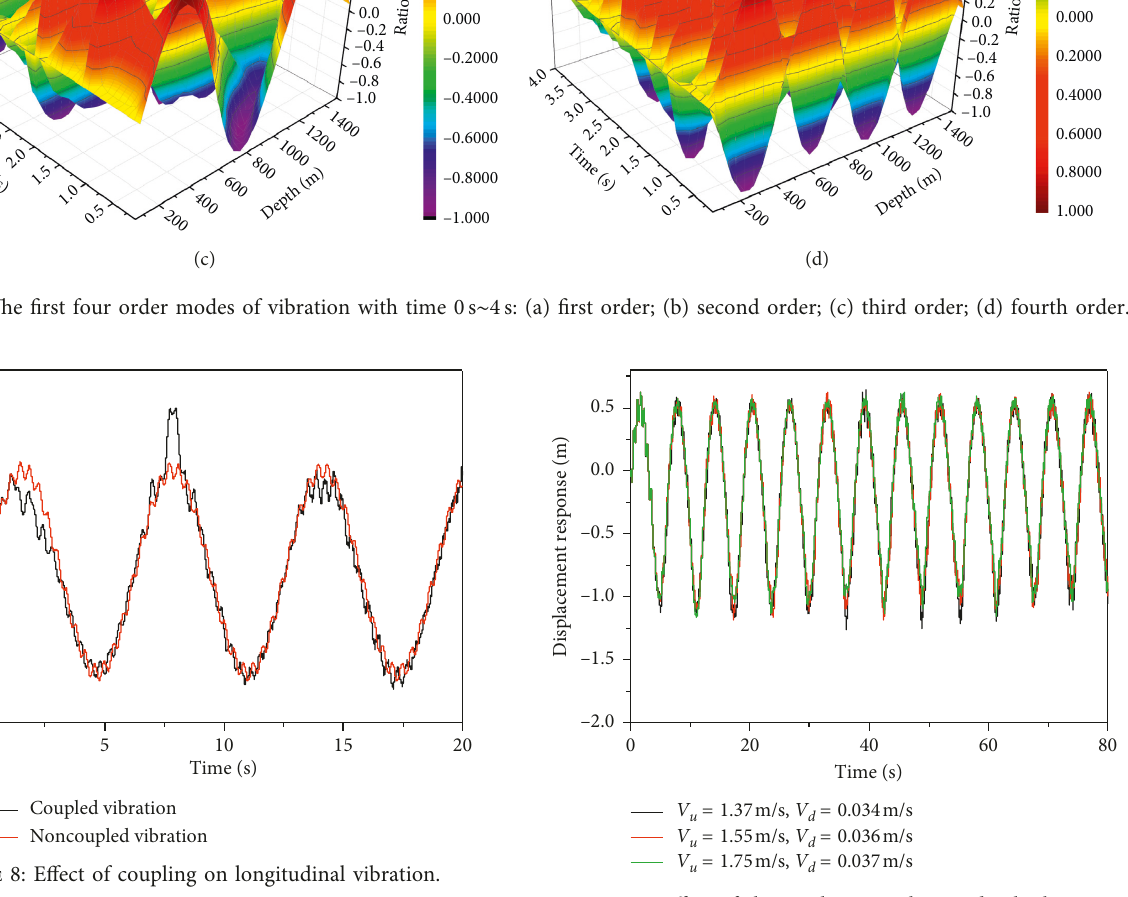
Figure 10: Effect of shear velocity on longitudinal